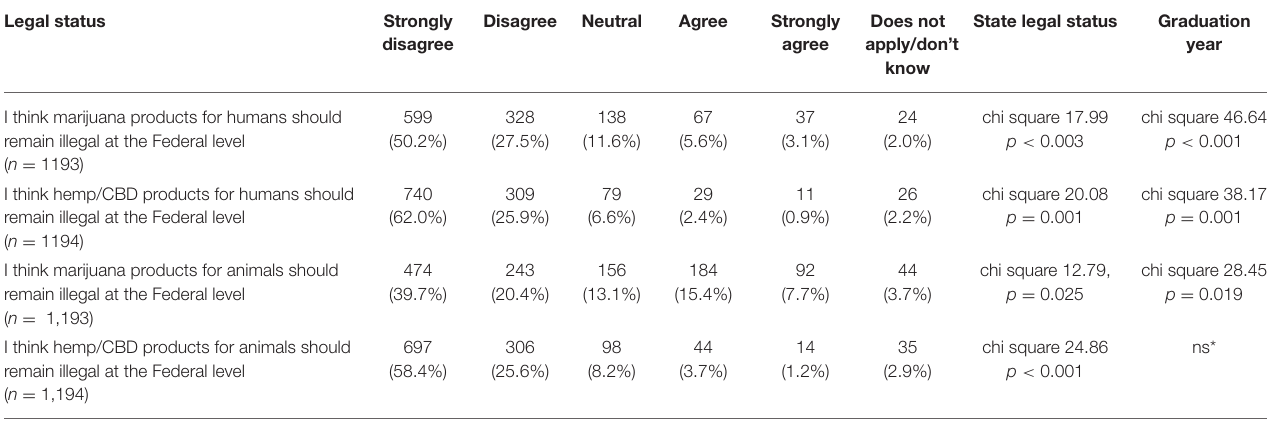
TABLE 10 | Participants’ views regarding legal status of hemp/CBD/marijuana in animals and humans. Legal status Strongly